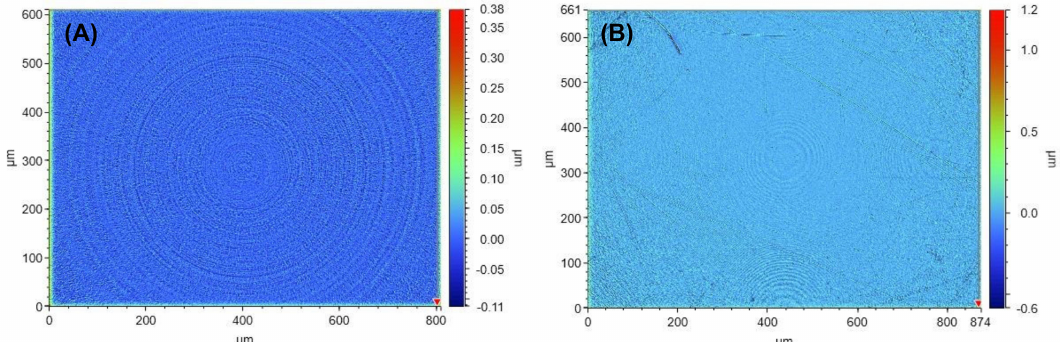
Figure 4. White light interferometer images from a female mould before ( A ) and after significant UV exposure ( B ). The coloured legend indicates the height of the roughness in µ